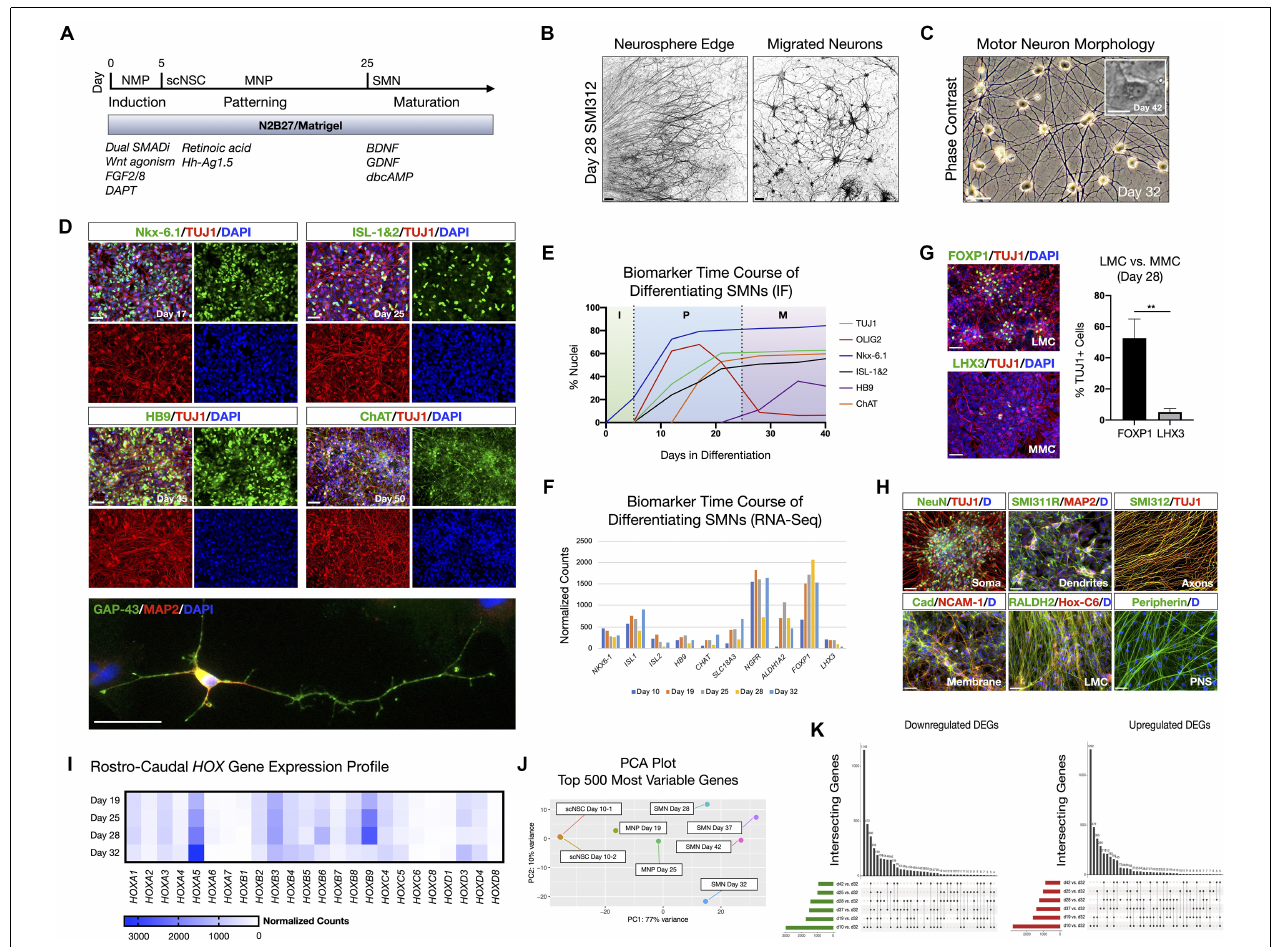
FIGURE 1 | hiPSC-derived scNSCs generate SMNs regionally-matched for the spinal cord. (A) Overview of differentiation protocol used to generate cervically-patterned SMNs through NMP, scNSC, and MNP stages. Small molecules and growth factors used in caudo-ventral patterning and maturation are listed. (B) Pan-axonal antibody SMI312 labeling of day 28 adherent neurosphere (NS) culture at NS edge (left) and more distal field of migrated neurons (right). SMI312 signal shown with inverted LUT. (C) Phase contrast images of day 32 SMN cultures. Inset is day 42 single SMN with characteristic trapezoidal shape and prominent nucleolus. (D) SMN hallmark biomarkers. Top: Motor progenitor spinal domain transcription factor Nkx-6.1 (day 17); SMN-related factors ISL-1&2 (day 25); Middle: SMN-specific HB9 (day 35); choline acetyltransferase enzyme ChAT (day 50); Cells are counterstained with TUJ1 and DAPI. Bottom: IF of single neuron. GAP-43/MAP2/DAPI (day 32). (E) Time course of biomarker expression in differentiating SMN cultures (I, induction; P, patterning; M, maturation). Percent of nuclei were counted from IF images. N = 3 fields were averaged per biomarker per time point (>100 cells per field). (F) Time course biomarker expression of differentiating SMN cultures by bulk RNA-Seq. (G) IF images and histogram of later motor column (LMC) SMN transcription factor FOXP1 (53 ± 12%; n = 349 cells) vs. medial motor column (MMC) SMN transcription factor LHX3 (5 ± 2%; n = 304 cells; two-tailed t test, t = 6.629, df = 4, ** P = 0.0027). (H) Visualizing neuronal compartments and SMN regional specificity by biomarker. (I) , RNA-Seq validation of cervical spinal cord identity by normalized Hox gene expression profile in differentiating SMN cultures. (J) PCA plot of 500 most variable genes during scNSC neuronal differentiation. (K) UpSet plots of intersecting downregulated (left) and upregulated (right) differentially expressed genes (DEGs) using individual time point comparisons in differentiation. Plot height represents the number of overlapping DEGs between the sets below marked with filled circles. Vertical lines connecting two or more dots denote the set of genes overlaps the connected sets. Data are reported as mean ± s.e.m. Scale bars are 50 µ m, and 10 µ m in (C)